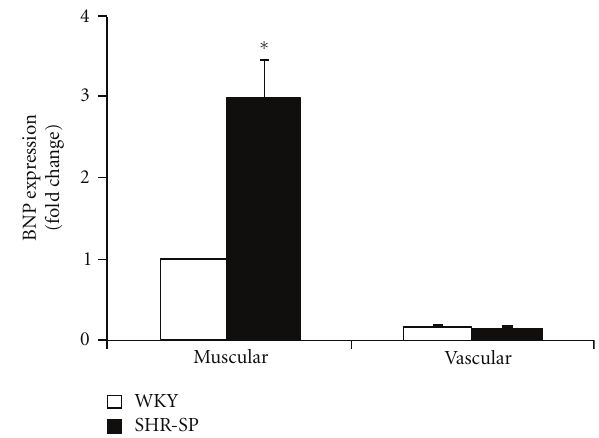
Figure 4: BNP mRNA expression in the muscular and vascular samples obtained from the heart of WKY (open column) and SHR- SP (closed column). BNP expression levels were expressed as fold change from the muscular sample of WKY. Unpaired t -test was used for comparison of initial data before expression as fold changes. Bar = 1 × SD ( n = 3). ∗ P < 0 . 05 versus